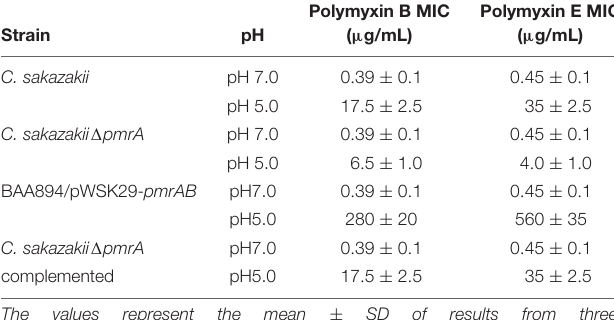
TABLE 2 | The minimal inhibitory concentrations of mutants derived from BAA894 cultured in pH 7.0 and pH